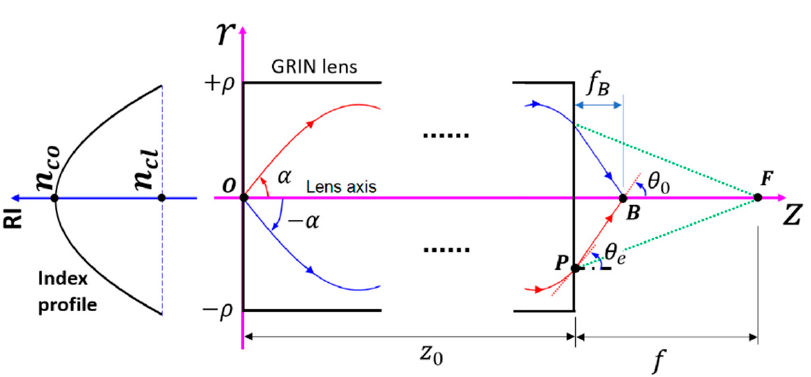
Figure 3. Coordinate system for describing the RI profile and ray trajectories in the meridional plane. The index profile is shown on the left.